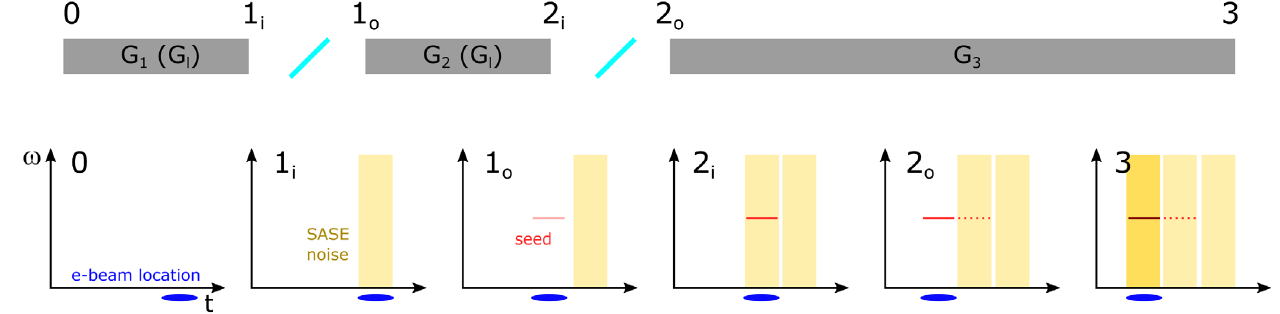
FIG. 5. Illustration of the radiation spectrogram evolutionin the two-stage self-seeding setup with locations notation used in this